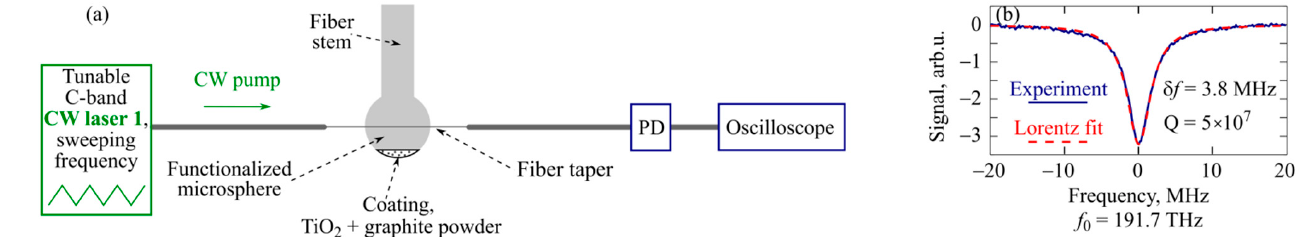
Figure 2. ( a ) Experimental setup for measuring Q-factors of microcavities. ( b ) Typical resonance curve of produced functionalized microsphere.